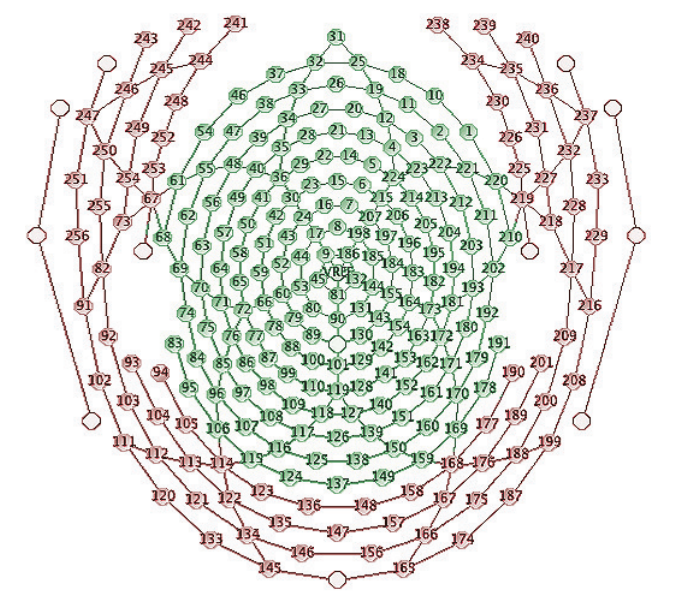
Figure 1. A 2D map of the 256 channel 256-channel HydroCel Geodesic Sensor Net. The considered electrodes are highlighted in green. The electrodes in red were discarded.